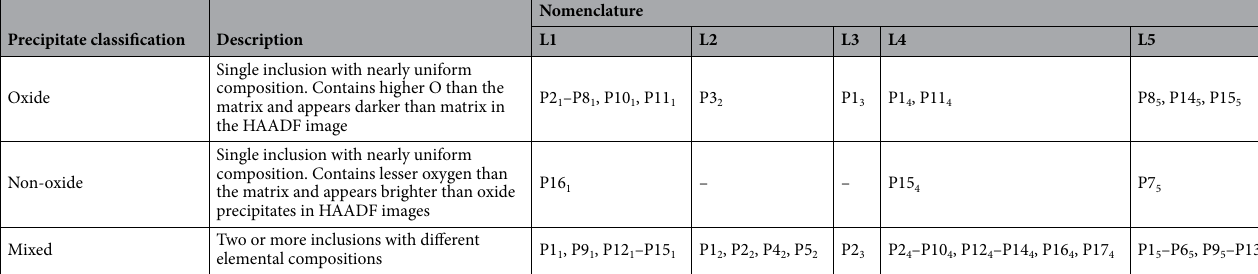
Table 1. Classification and nomenclature of precipitates in lamellae L1–L5. Precipitates are classified into oxides, non-oxides and mixed based on the oxygen content (in EDS maps) and brightness (in HAADF image) with respect to the surrounding (austenite) matrix. Each precipitate is numbered according the sequence shown in the HAADF images in Fig. 2 and the lamella number is added as a